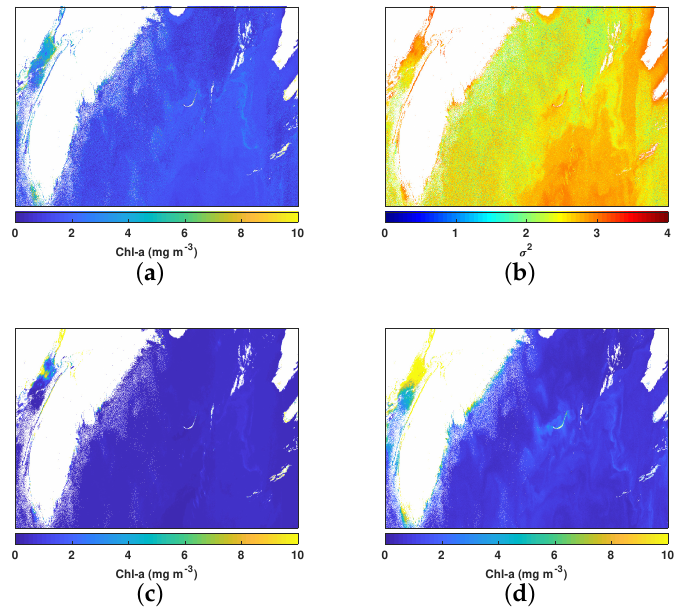
Figure A5. Estimated Chl-a in coastal and open Arctic waters: ML GPR Balaton model ( a ) and corresponding certainty map ( b ), NN ( c ) and OC4 ( d ). The unit of Chl-a is mg m − 3